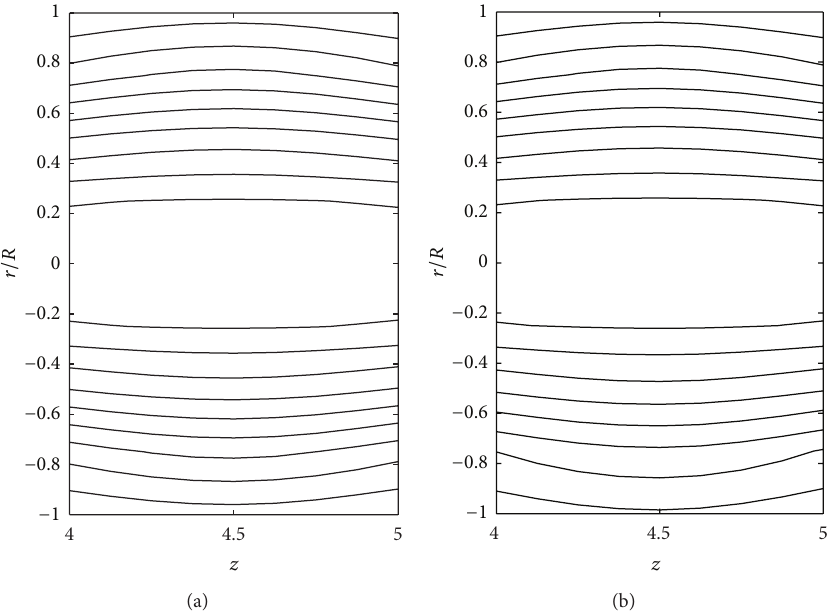
Figure 17: Stream lines for (a) Newtonian fluid and (b) Bingham-plastic fluid taking 𝛿 2 = −0.2 and 𝜁 = 0.01 in the dilatation region.